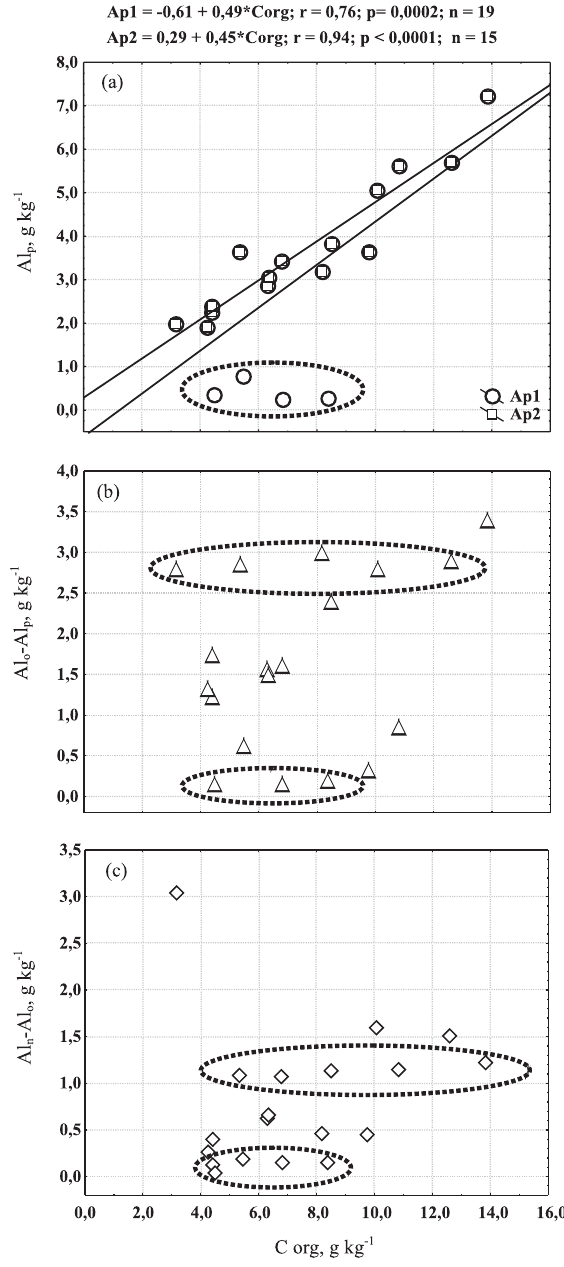
Figura 5. Relação entre o teor de carbono orgânico (Corg) e o de (a) Al extraído com pirofosfato (Al